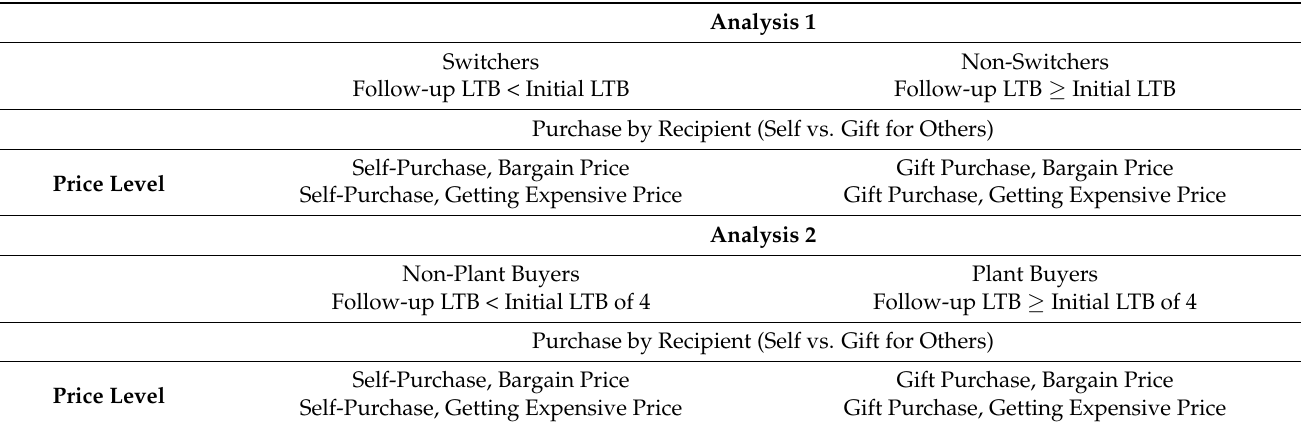
Table 1. Four treatment groups used to analyze inconsistency in likelihood to